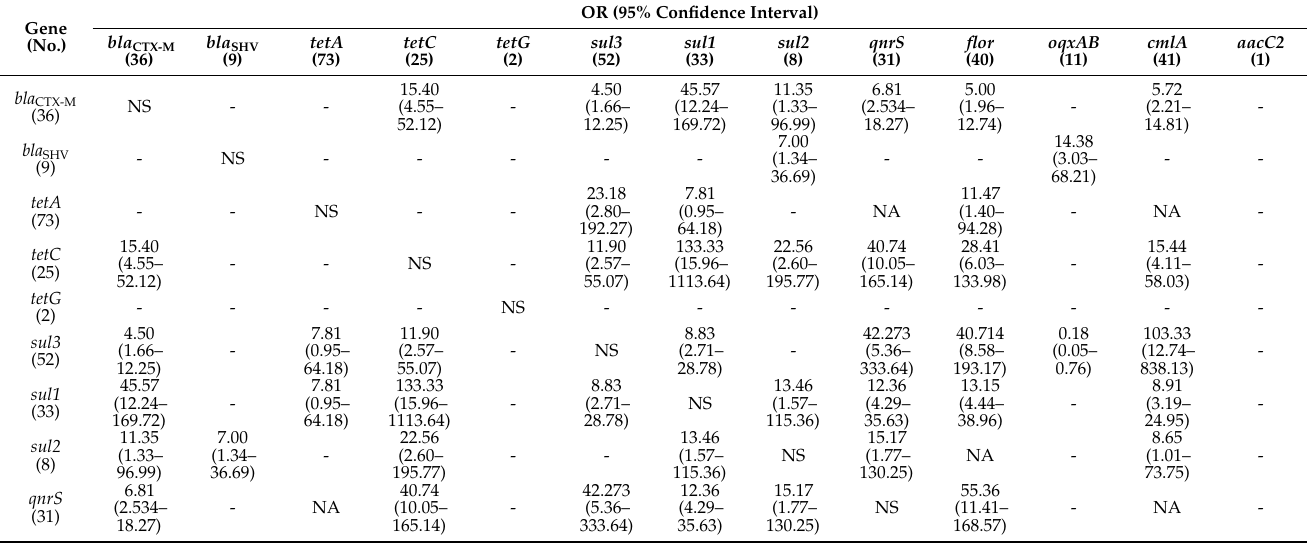
Table 3. Odds ratios (OR) of antibiotic resistance genes in E. coli isolates from captive giant pandas (n =